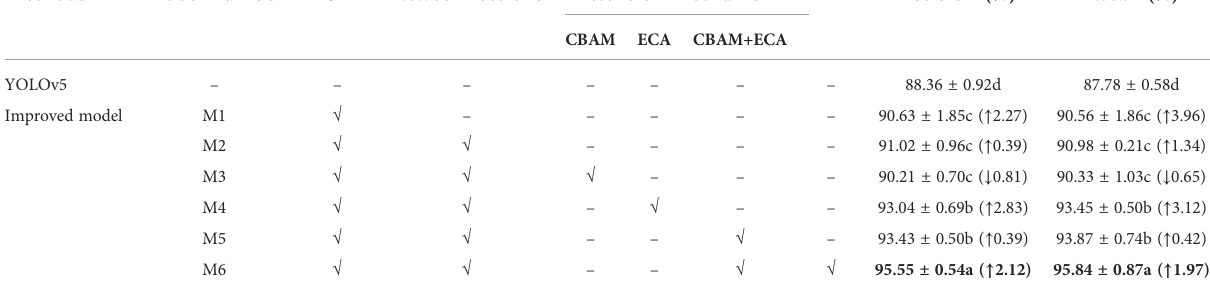
with that using original